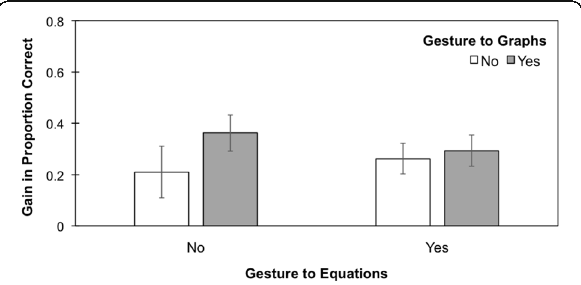
Fig. 1 Average unadjusted gains in proportion correct on encoding graphs from pretest to posttest, as a function of condition. The error bars represent standard errors